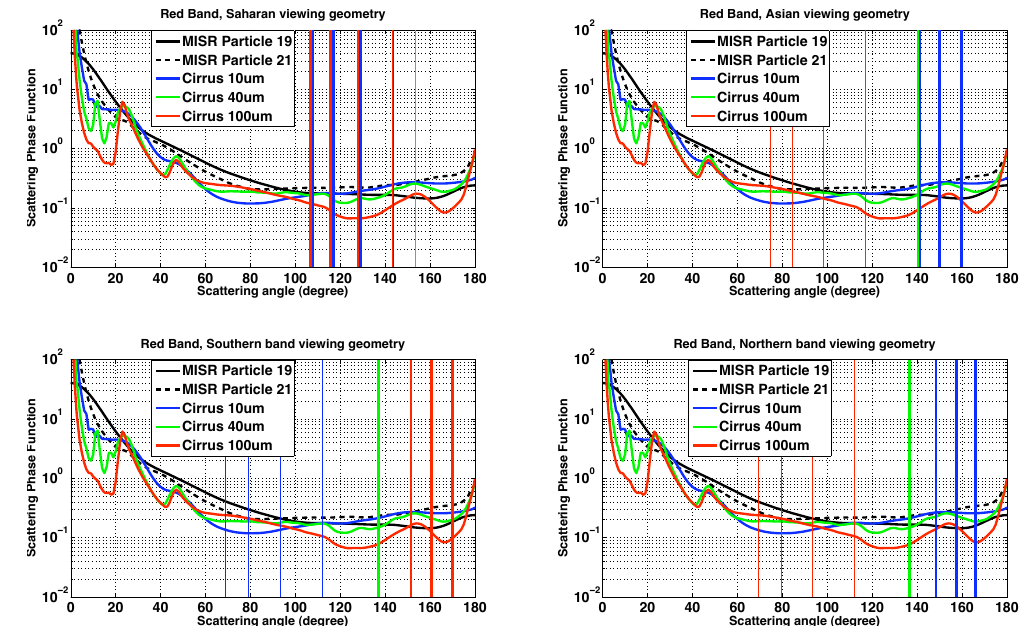
Fig. 12. Same as Fig. 11 but comparing MISR Particle 19 and Particle 21 (coarse dust) with three cirrus particles: D e = 10µm, D e = 40µm, and D e =